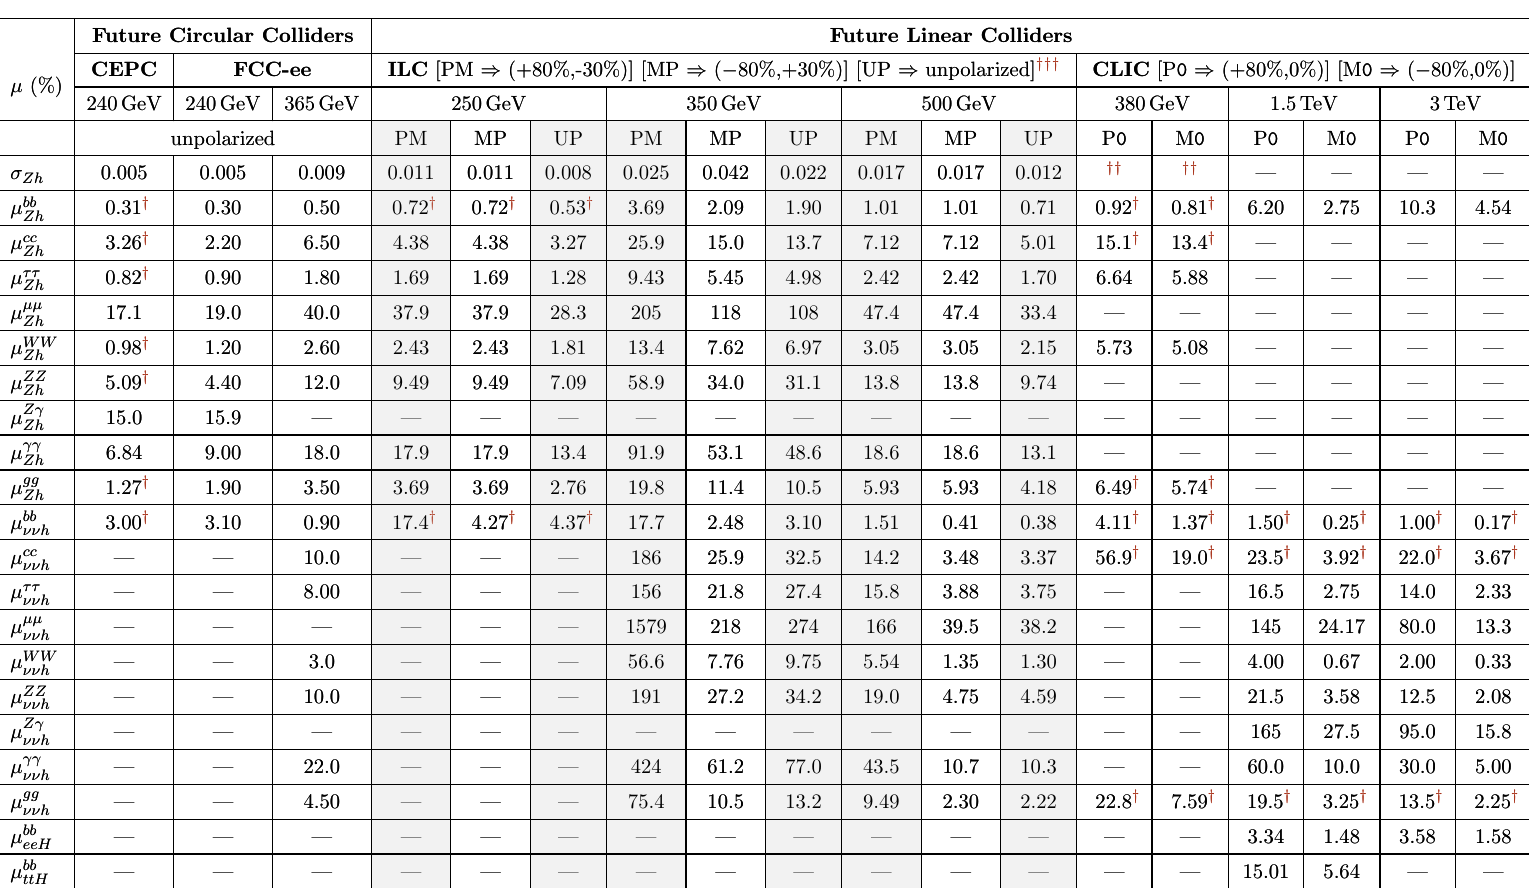
Table 8 . The Higgs signal strength inputs used for the (cid:12)ts in this work. All the numbers are in %. The details of some derivations made for some of the colliders are given in the text. The couplings marked with y are correlated. The correlation matrices are given separately in the text and in the ancillary (cid:12)les. yy For the projections of (cid:27) Zh for CLIC see text. yyy The details of how we derived the projections for di(cid:11)erent beam polarization (marked in grey) at the ILC can be found in subsection